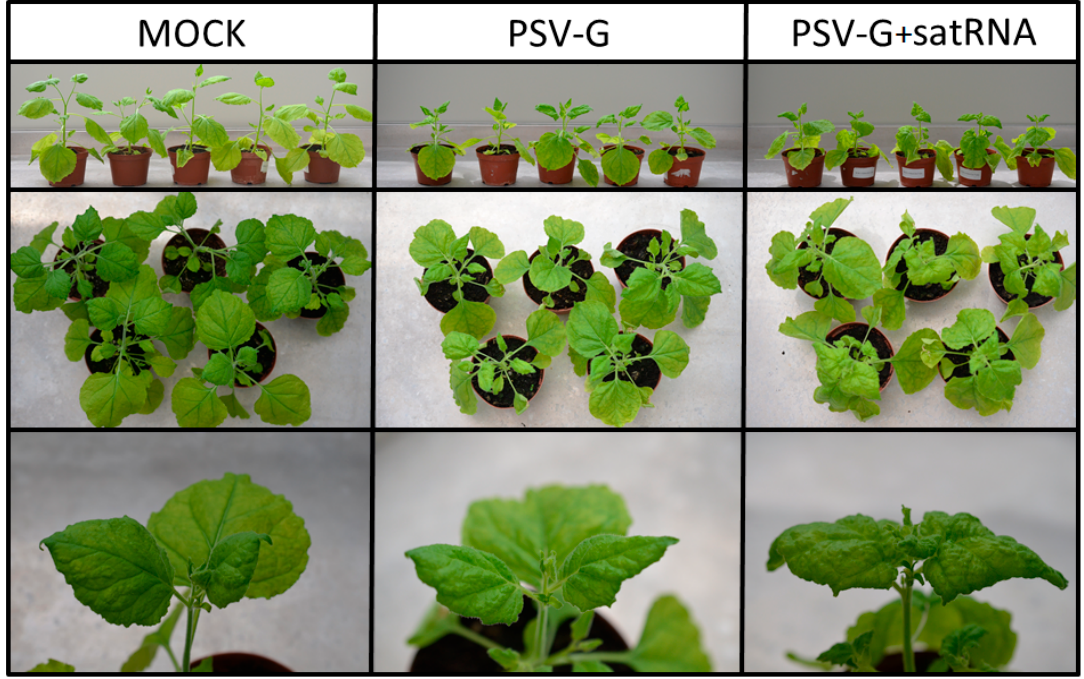
Figure 1. Comparison of healthy and infected N. benthamiana plants grown at 21 °C. Mock, not infected (left panel), infected with PSV-G-genomic transcripts (GT) (middle), and co-infected with PSV-G-GT + satRNA (right panel).